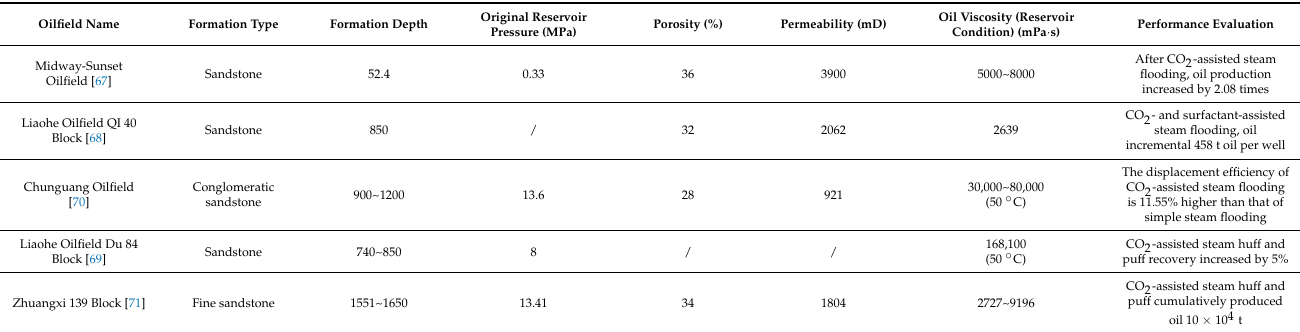
Table 2. Field applications of CO 2 -assisted steam flooding.